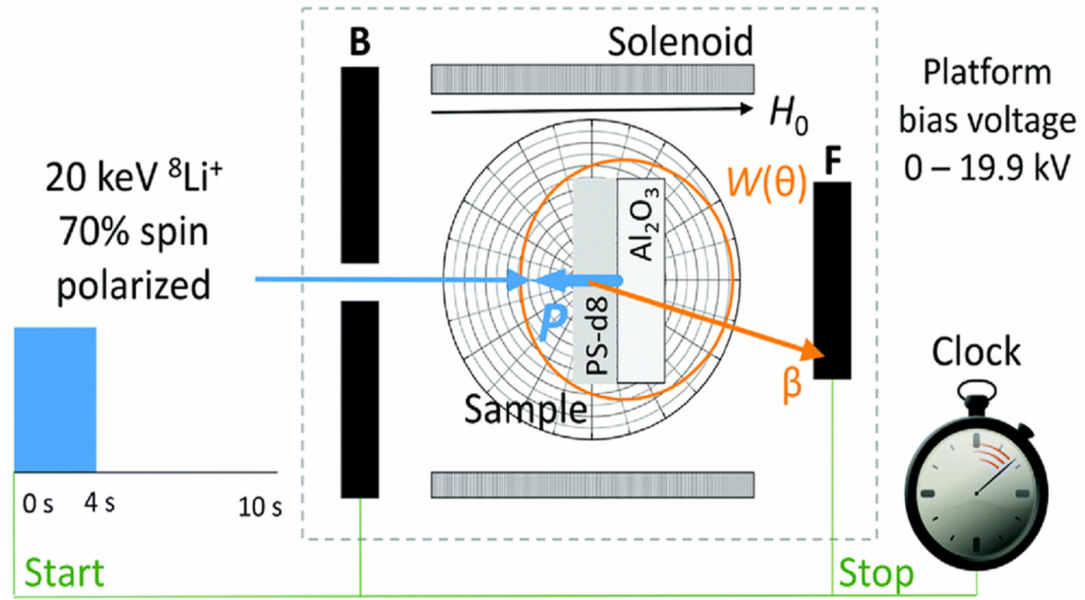
Figure 8. A schematic description of the β -NMR setup where the experiment starts with a 4 s long 8 Li + pulse, followed by the β particles emitted anisotropically during the decay of spin-polarized nuclei. The β trajectory (orange line) is shown hitting the detector. Reproduced with permission. [149] Copyright 2017, The Royal Society of